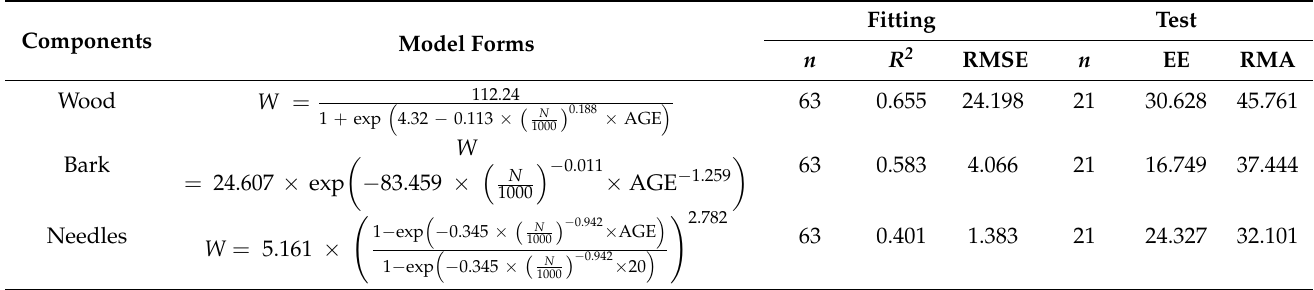
Table 3. The estimation result of the SBA. W is the biomass of each component (wood, bark, needles, and branches), above-ground, and roots biomass of the stand. N is the stand density, and AGE is the stand